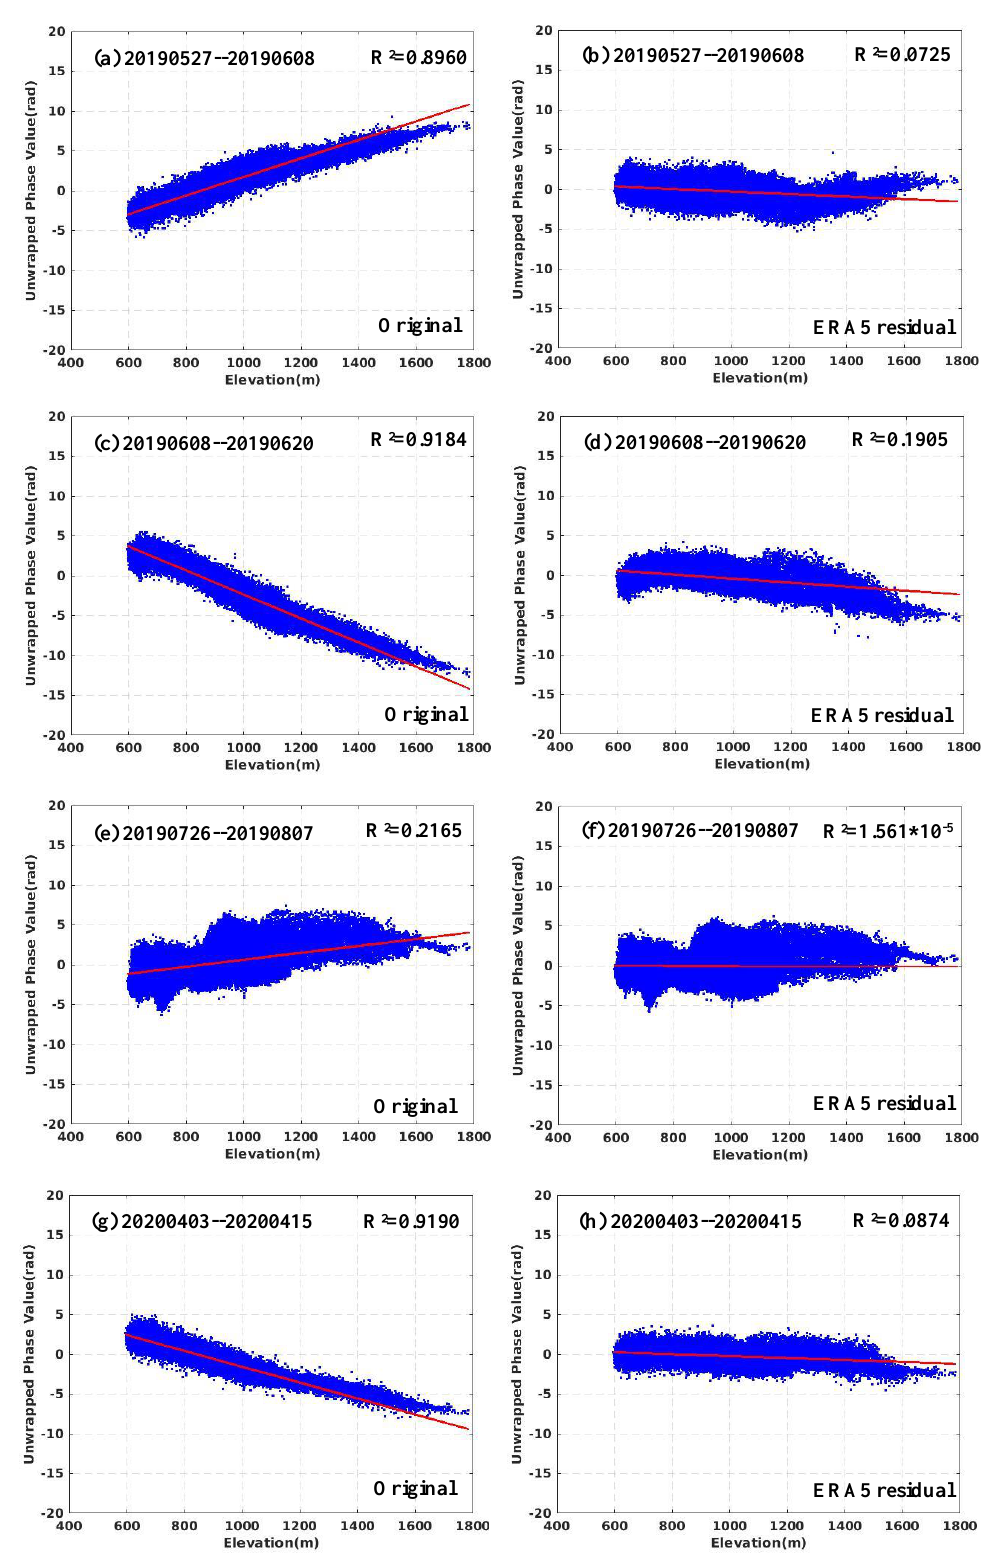
Figure 7. Unwrapped phase-elevation scatter plots for original phase and ERA5 residual phase. ( a , c , e , g ) represents the original phase-elevation of 20190527–20190608, 20190608–20190620, 20190726– 20190807 and 20200403–20200415, respectively. ( b , d , f , h ) represents the residual phase-elevation of corresponding time,